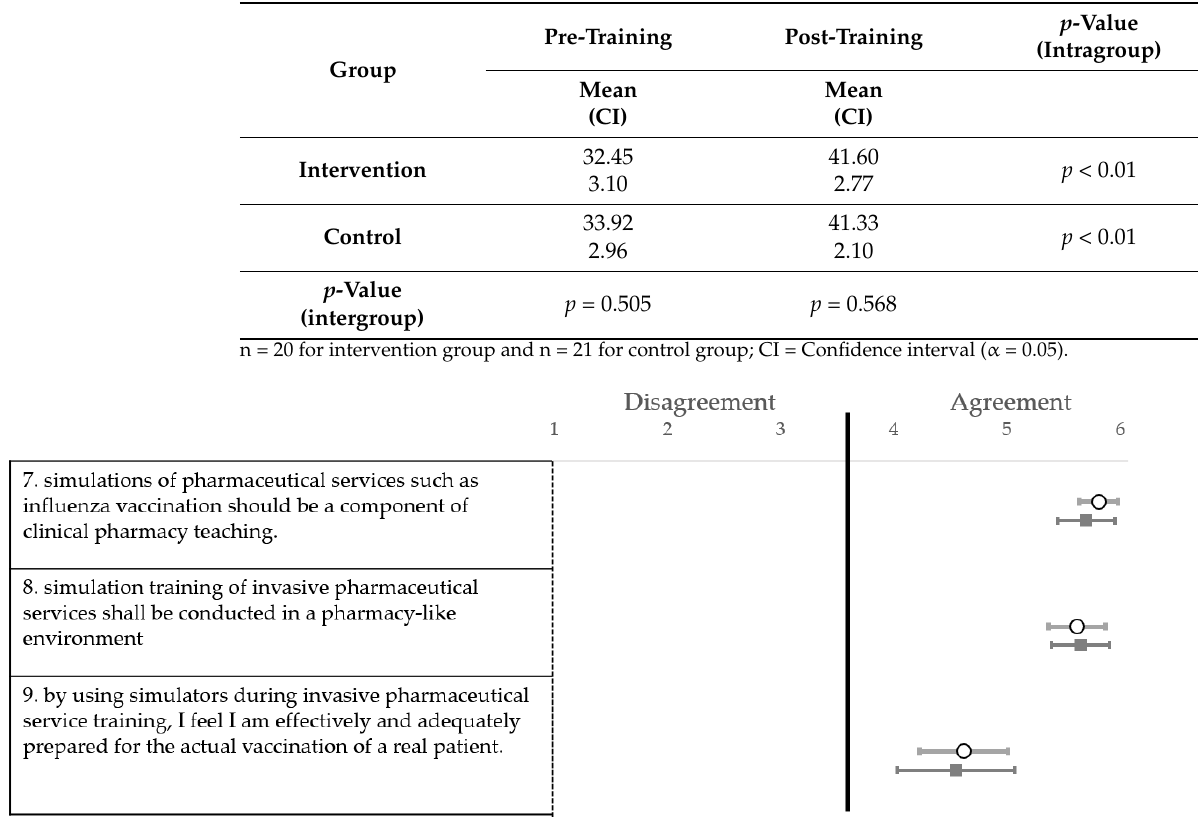
Table A1. Achieved scores by intervention and control group in pre- and post-training self-Assessment.